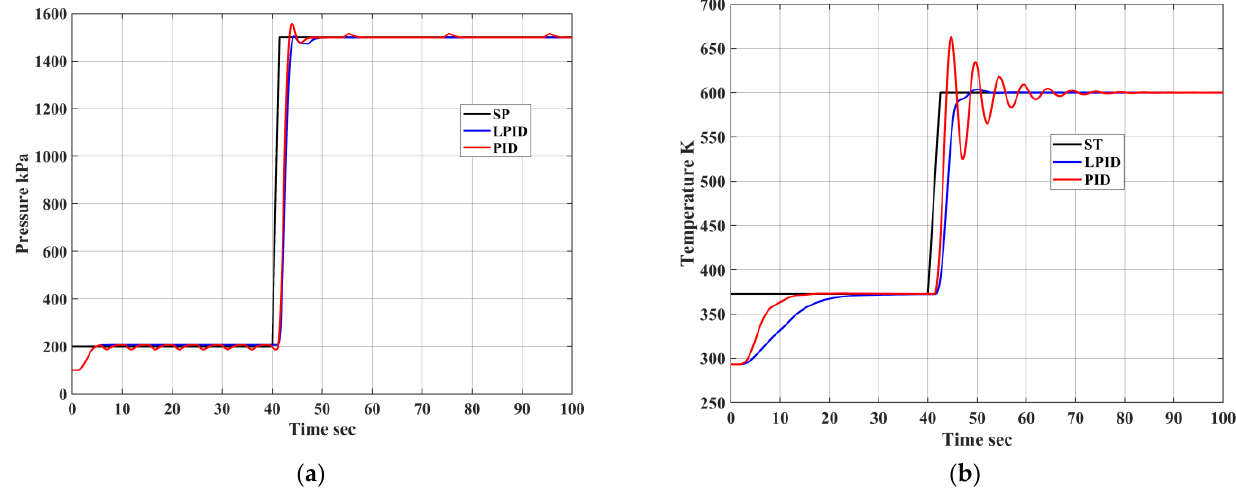
Figure 6. Dynamic response simulation with the PID and LPID controllers of ( a ) a low range of pressure variation; ( b ) a low range of temperature variation.